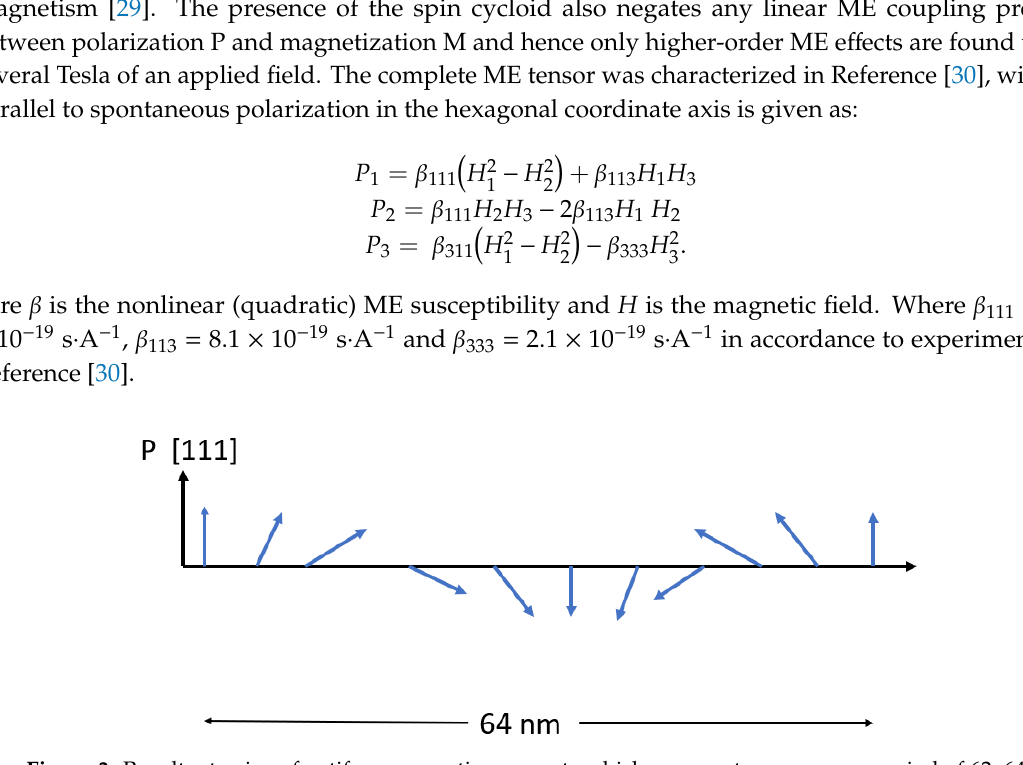
Figure 3. Resultant spins of antiferromagnetic moments which average to zero over a period of 62–64 nm forming the spin cycloid, contained in the polarization plane usually seen in bulk material P [111]. Table 2. Properties of Bismuth